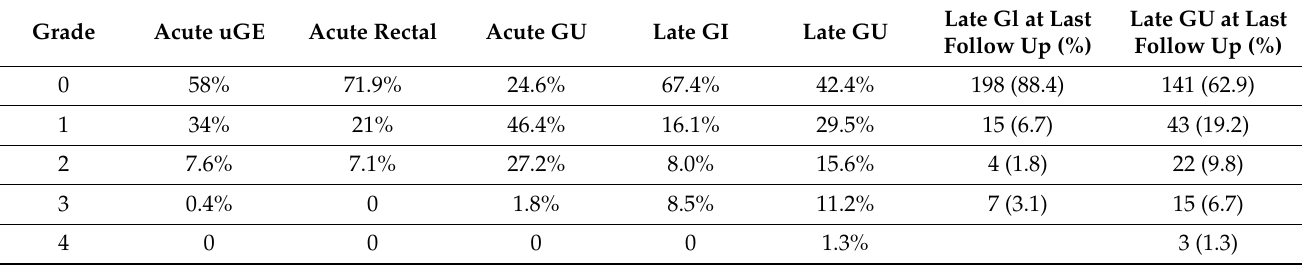
Table 4. Acute and late toxicities and prevalence of late toxicities at last follow-up.